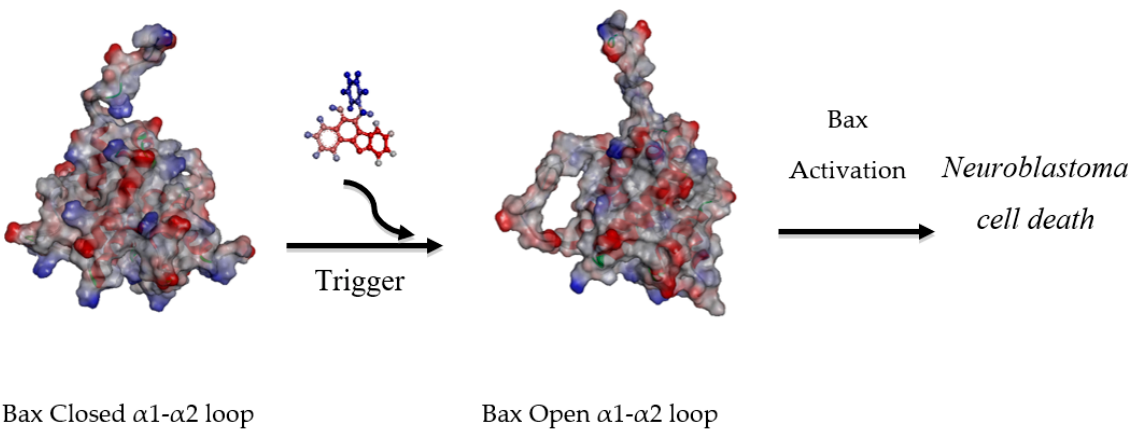
Figure 8. Predicted model of Bax activation initiated by displacement of the α 1- α 2 loop from a closed to an open conformation induced by the ligands examined in the present study.